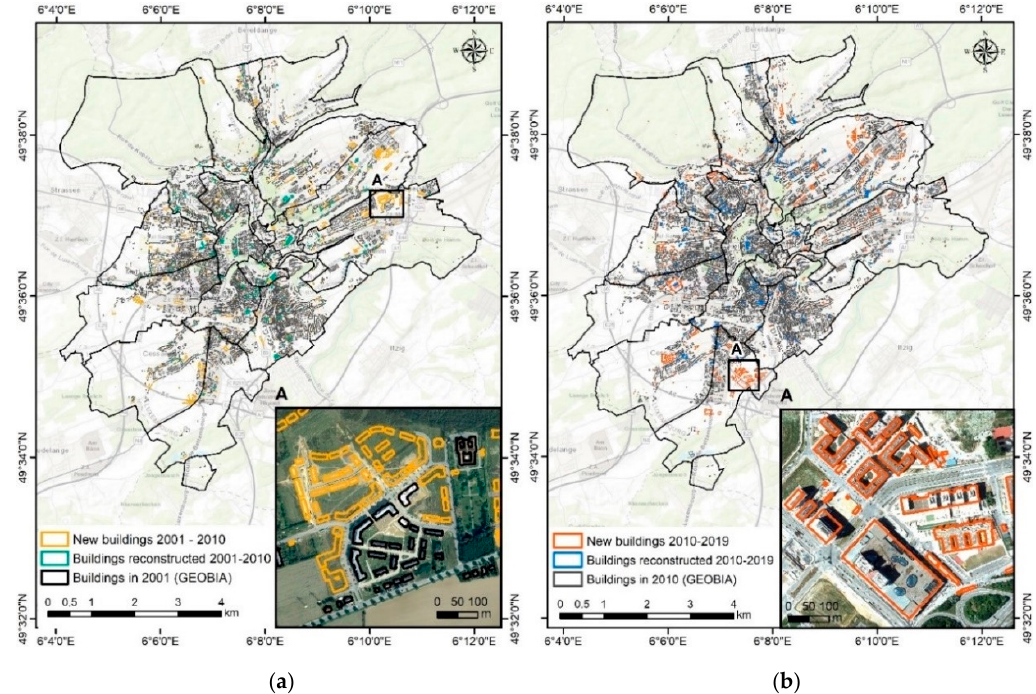
Figure 8. New and reconstructed buildings between ( a ) 2001–2010 and ( b ) 2010–2019 in Luxembourg City.